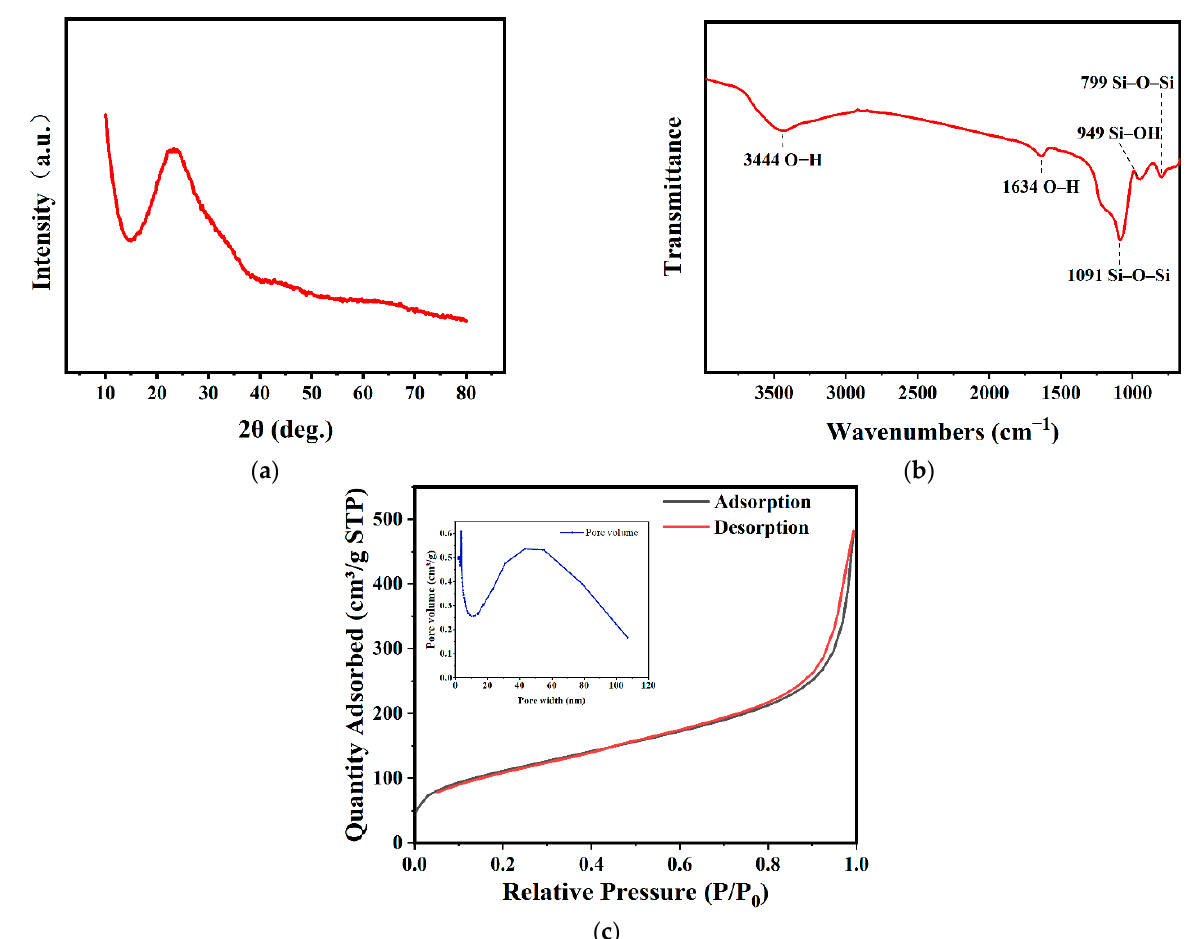
Figure 2. Results of physico-chemical analysis of Navicula australoshetlandica sp. diatom frustules: ( a ) Fourier transform infrared (FTIR) spectrum; ( b ) X-ray diffraction (XRD); and ( c ) nitrogen adsorption/desorption isotherms (77.4 K) and pore width distribution, calculated from the adsorption branch by applying BJH method.